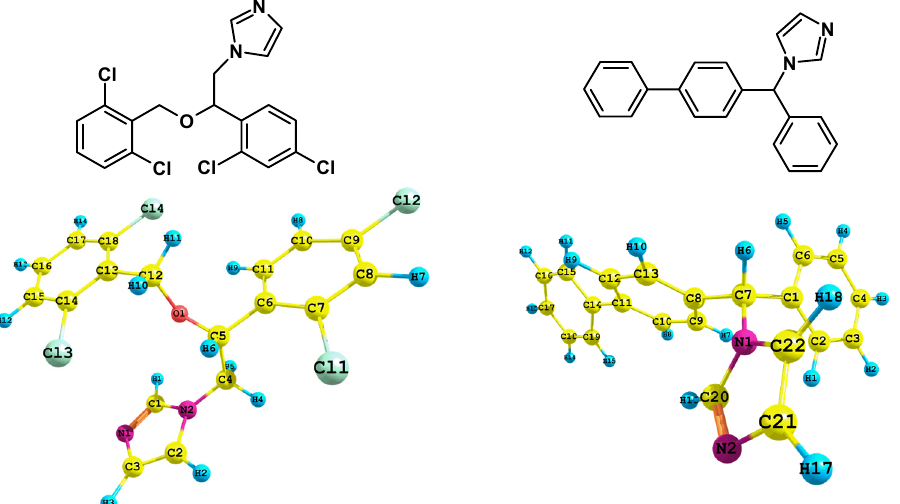
Figure 1. Formulas for isoconazole ( 1 ) and bifonazole ( 2 ) and their optimized geometry at the CAM-B3LYP/6-31G(d,p) ( 1 , left ) or B3LYP/6-31G(d,p) levels of theory ( 2 , right ).